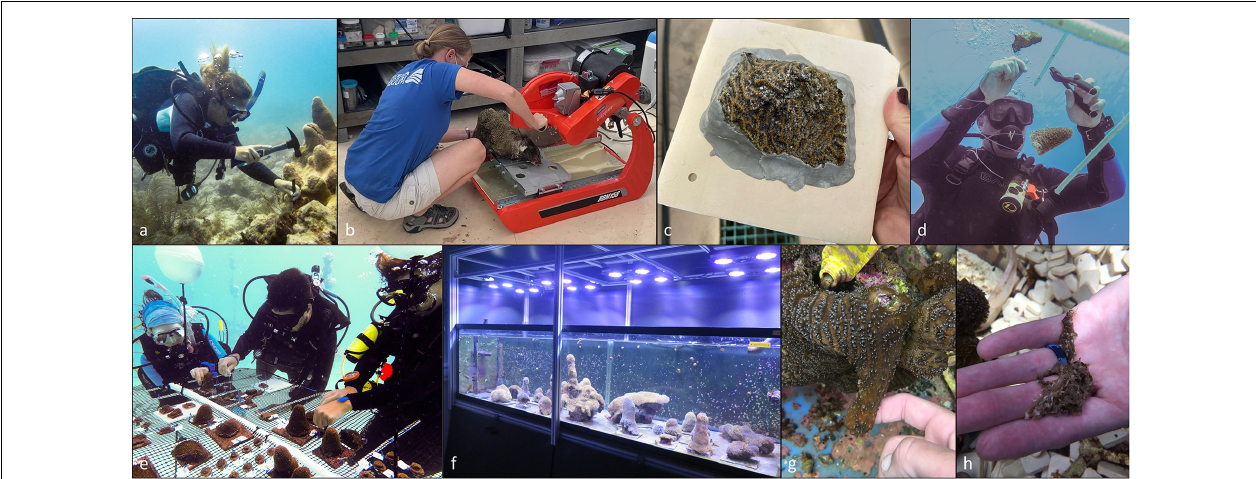
FIGURE 1 | Collection, preparation, and care of Dendrogyra cylindrus rescue fragments. Fragments were collected from the reef using hammer and chisel (a) . Excess skeleton was trimmed (b) and fragments were mounted on tiles (c) . Early fragments in offshore nurseries were suspended from trees (d) , but all offshore holding eventually moved to mounted fragments (e) . Onshore fragments were held in a variety of aquarium systems (f) . Development of gemmae on rescue fragments appeared as an attached growth of soft tissue (g) with internal skeletal fragments (h) .